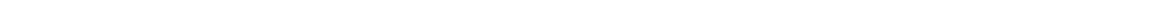
Fig. 4 FMP-API-1 increases urine concentrating ability. a Dose-response studies of FMP-API-1. (Left) FMP-API-1 (100 – 1500 µ M) was added to the basolateral side of the mpkCCD cells for 1 h. (Right) Non-glycosylated AQP2 bands were quanti fi ed by densitometric analysis, and the results are presented in the bar graphs as the fold change, as compared to the values of the control cells. Bars are mean values ± SD of three experiments. Asterisk indicates a signi fi cant difference compared with control. Tukey, * p < 0.05, ** p < 0.01. b Dose-response studies of H89. FMP-API-1 (900 µ M) was added